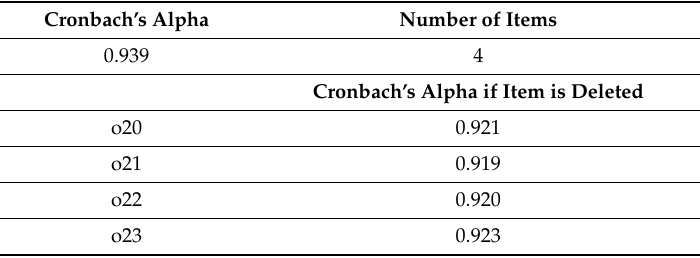
Table 6. Reliability analysis for factor